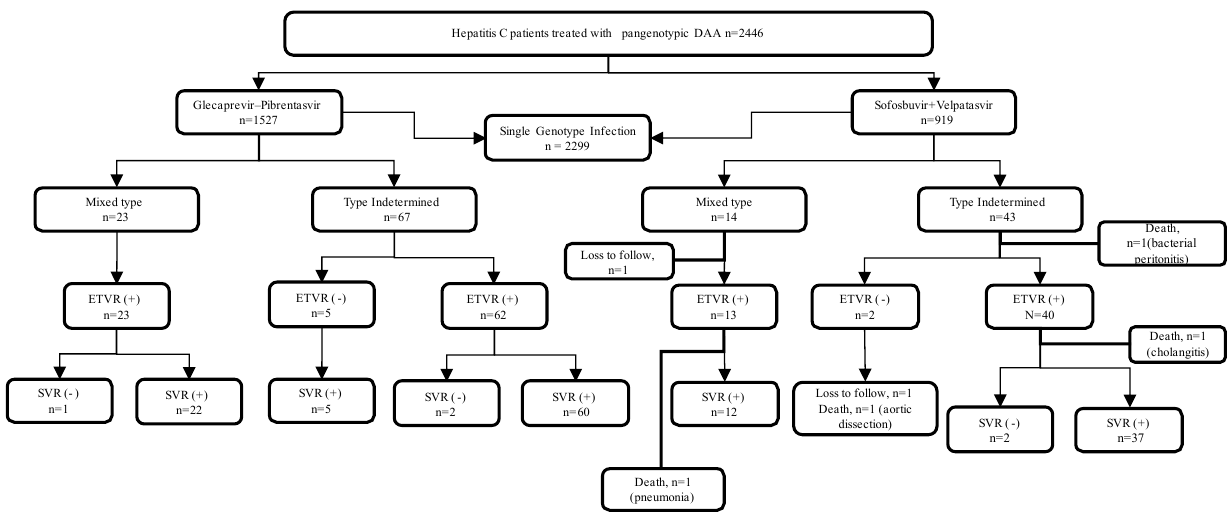
Figure 1. Flowchart of the study